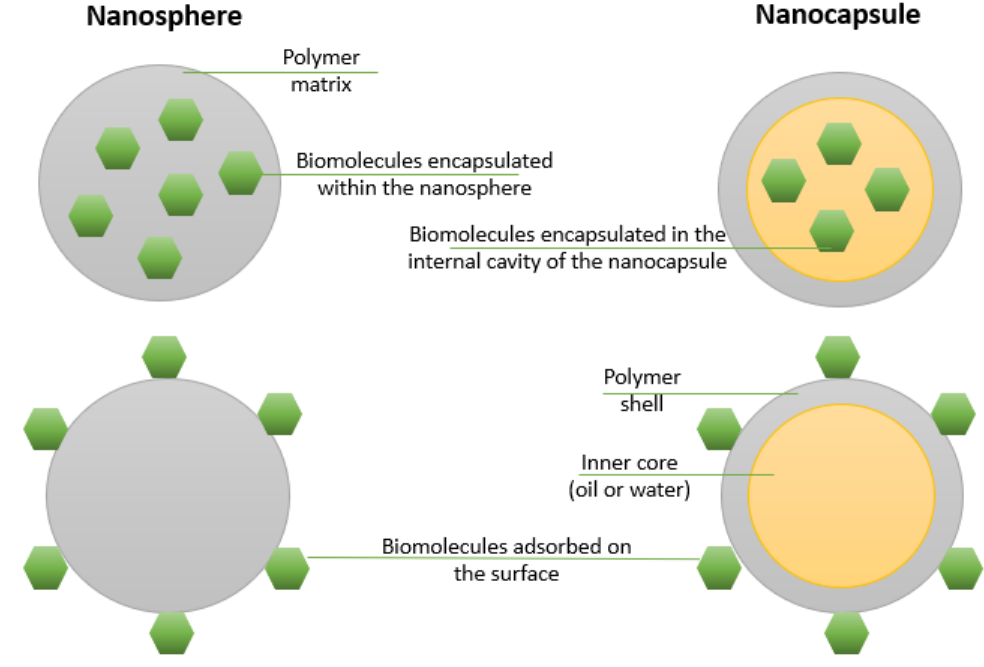
Figure 2. Schematic representation of nanosphere and nanocapsule drug association possibilities. Created based on information from literature references [172–174].